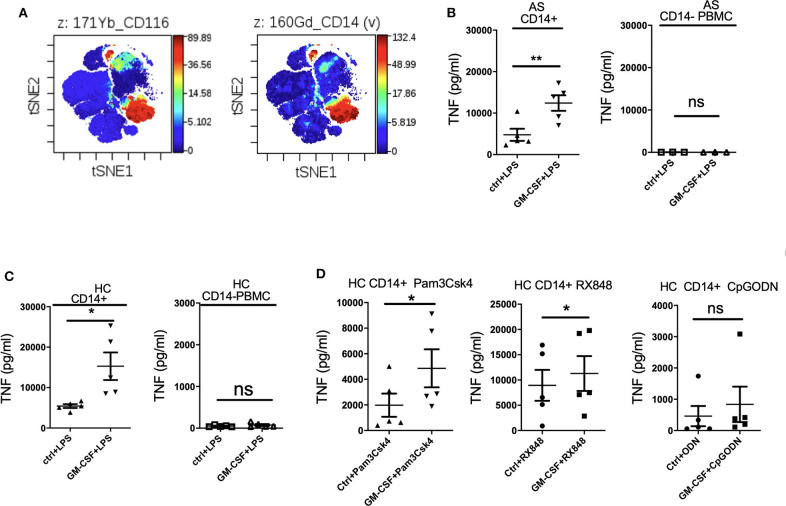
GM-CSF-potentiation of TNF production by LPS-stimulated PBMCs is contributed primarily by CD14+ monocytes. GM-CSF potentiates the response of monocytes to agonists for multiple TLRs. (A) GM-CSF receptorα(CD116) expression on CD14+ monocytes. CyTOF analyzed by viSNE clustering analysis of all live CD116 (GM-CSF Receptor α) events from PBMCs from a HC. Representative of N = 1. (B,C) CD14+monocyte (n = 5 AS patients and HCs) or CD14-depleted PBMCs (n = 3 AS patients) were treated with GM-CSF for 2 h followed by LPS (10 ng/ml) stimulation overnight. (D) CD14+ monocytes isolated from 5 HCs were treated with GM-CSF then with 15 ng/ml Pam3Csk4 or 1 μg/mlRX848 (resiquimod) or 10 μM CpGODN overnight. TNF levels in supernatant were determined by ELISA. Data are represented as mean and SEM of independent experiments, p-value was calculated using paired t-test, *p < 0.05, **p < 0.01, ns: not significant.